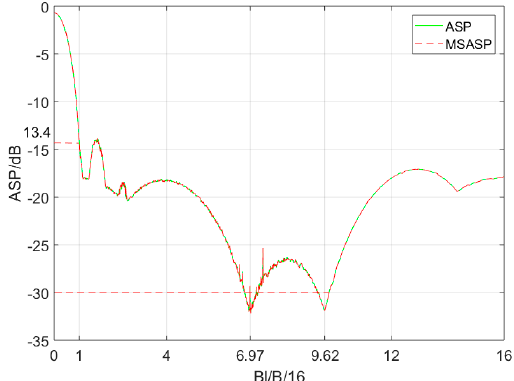
Figure 6. Time-frequency structure of designed OFDM chirp waveform, M = 16. ( a ) During a pulse and B l n / B = 6.97 / 16; ( b ) During 16 pulses and B l n / B = 6.97 / 16.